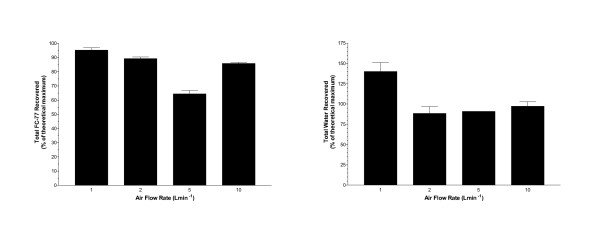
Recovery Percentages. Percentages of the theoretical maximum recovery for FC-77 and water at different flow rates (mean ± sem). For FC-77, 1 and 2; 2 and 10 Lmin-1 are significantly different (p < 0.05). For water, 1 Lmin-1 is significantly different (p < 0.05) from all other rates.